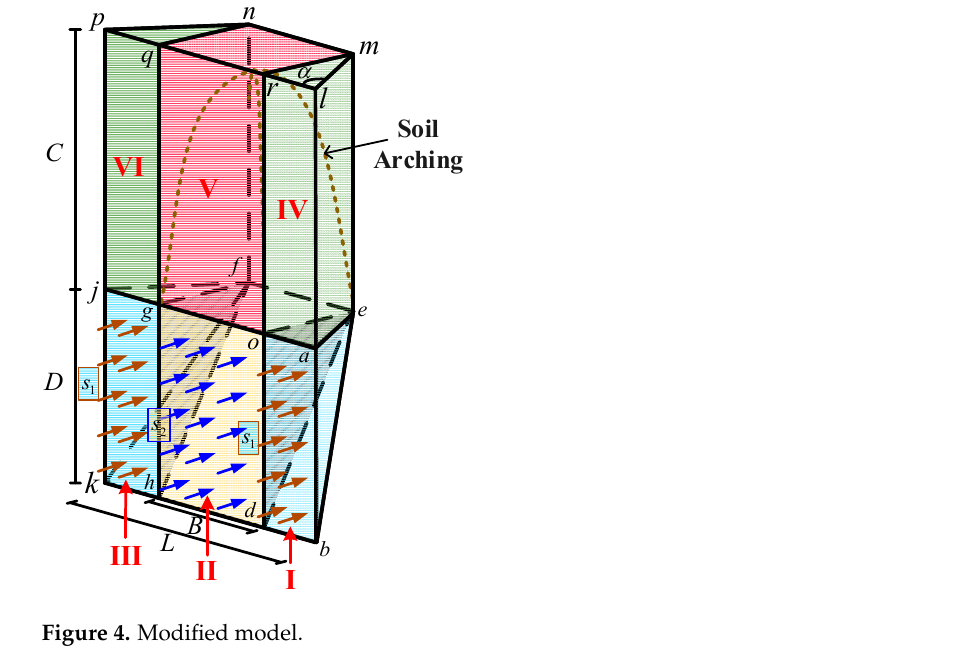
Figure 3. Profile of box tunneling.